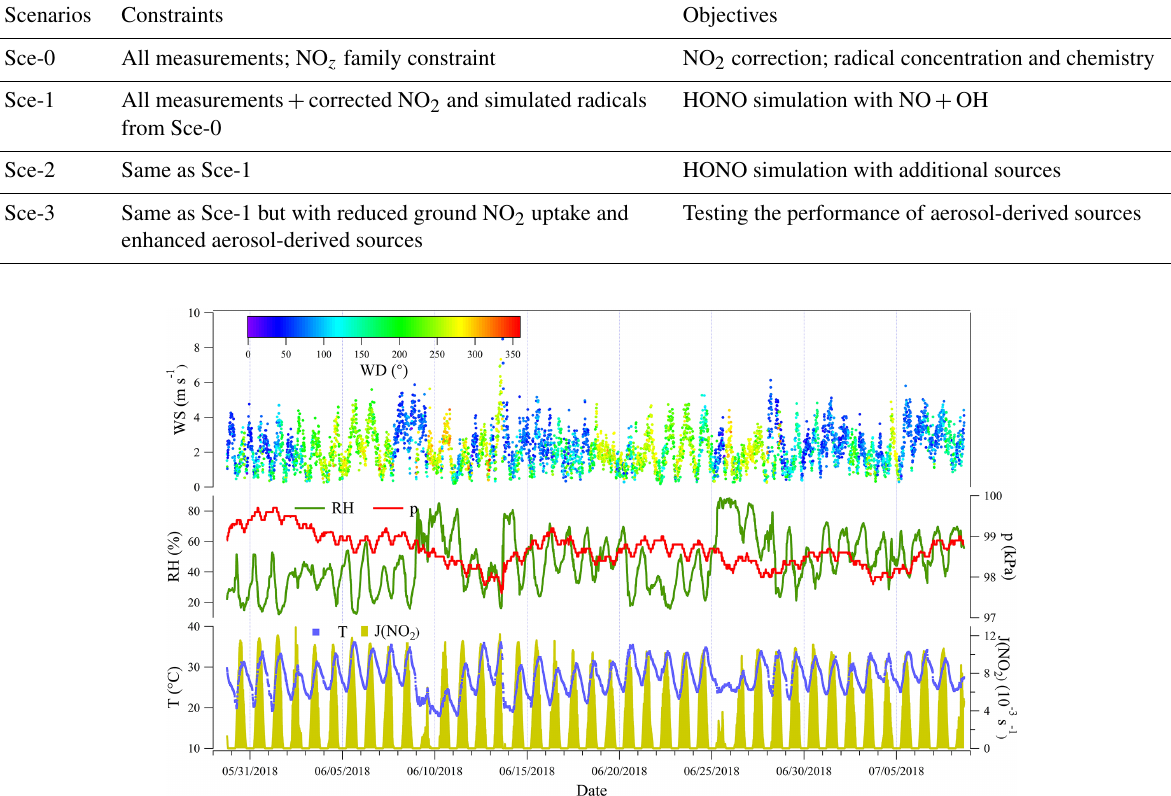
Figure 1. Meteorological parameters measured at the foot of Mt. Tai during the